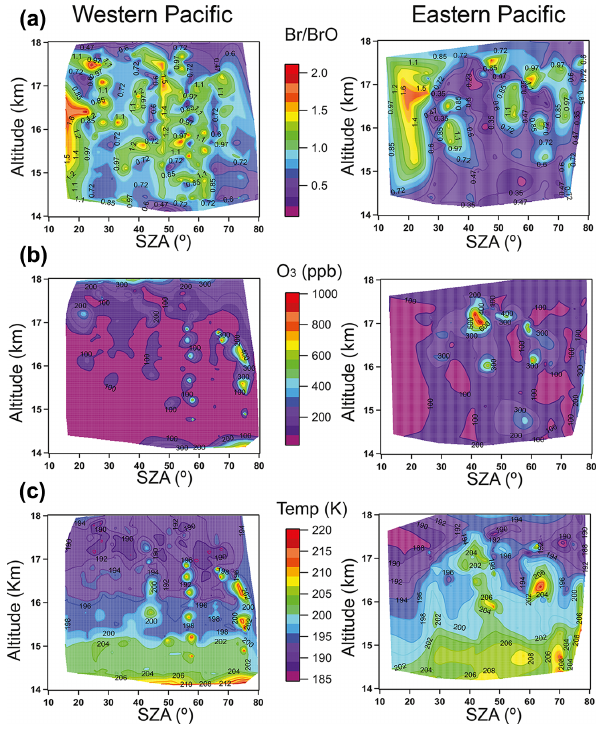
Figure 9. CAM-Chem model estimates of the daylight Br / BrO ra- tio (a) , ozone (b) , and temperature (c) as a function of SZA over the WP and